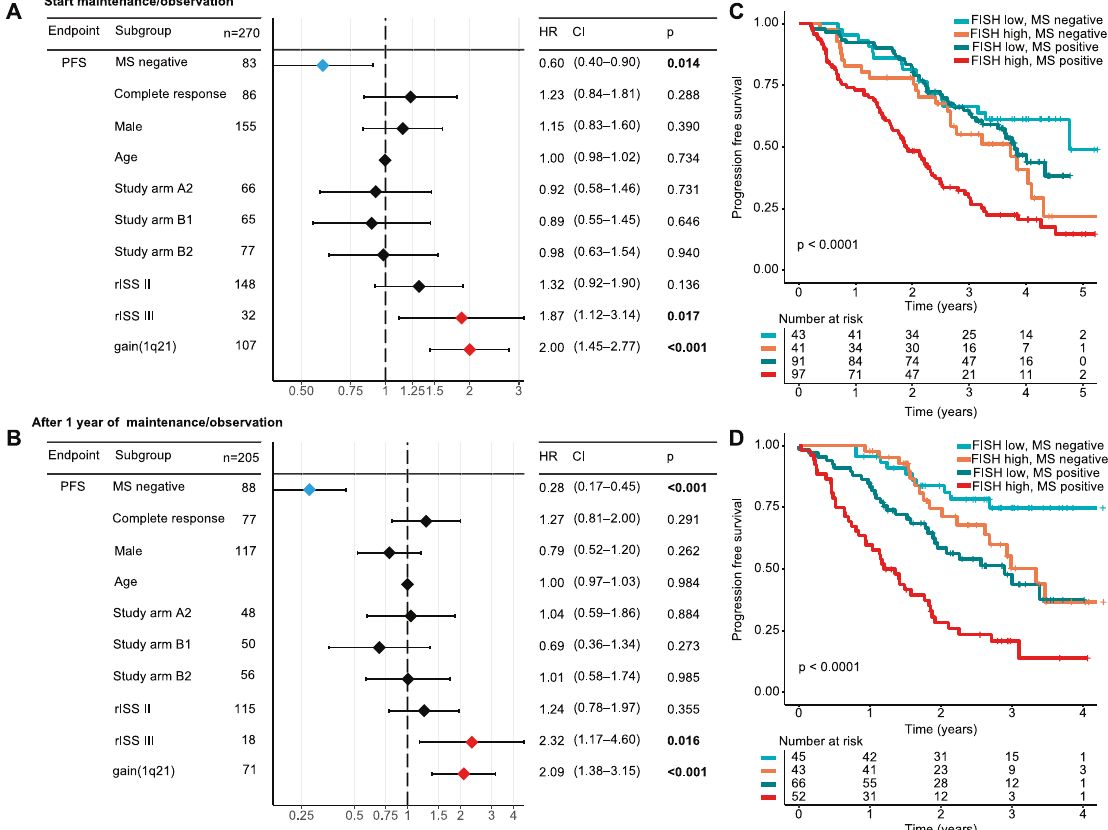
Fig. 3 Independent prognostic impact of mass spectrometry and its combination with established high-risk markers. Results of a multivariable model for PFS from the start of maintenance therapy/observation ( A ), and after one year (±3 months) of maintenance/ observation ( B ). PFS from start of maintenance therapy ( C ) and after one year of maintenance/observation ( D ) strati fi ed by the combination of mass spectrometry (MS) and baseline high-risk cytogenetics. High-risk cytogenetics were de fi ned by the presence of t(4;14), t(14;16), del(17p) and/or gain(1q21). Study arms: A1 = PAd induction therapy and lenalidomide maintenance independent on response status; A2 = VCd induction therapy and lenalidomide maintenance independent on response status; B1 = PAd induction therapy and lenalidomide maintenance if less than complete response or observation in case of complete response; B2 = VCd induction therapy and lenalidomide maintenance if less than complete response or observation in case of complete response. FISH fl ourescence in situ hybridization, MS mass spectrometry, rISS revised International Staging System.